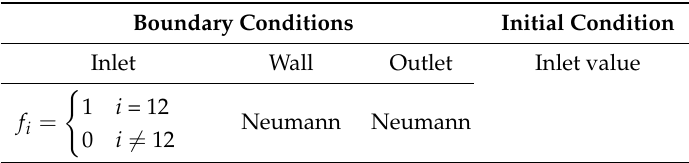
Table 10. Boundary and initial conditions for f i equations (25